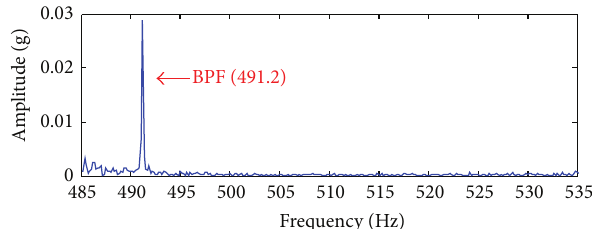
Figure 11: Zoomed-in spectrum under normal condition.